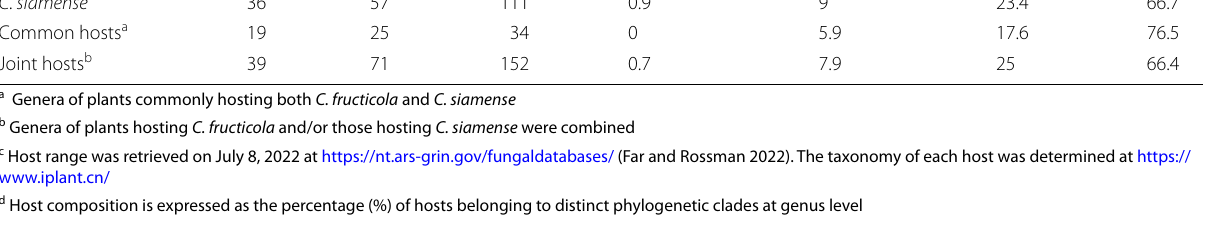
Table 2 Host range of the predominant Colletotrichum spp. causing strawberry anthracnose crown rot Colletotrichum